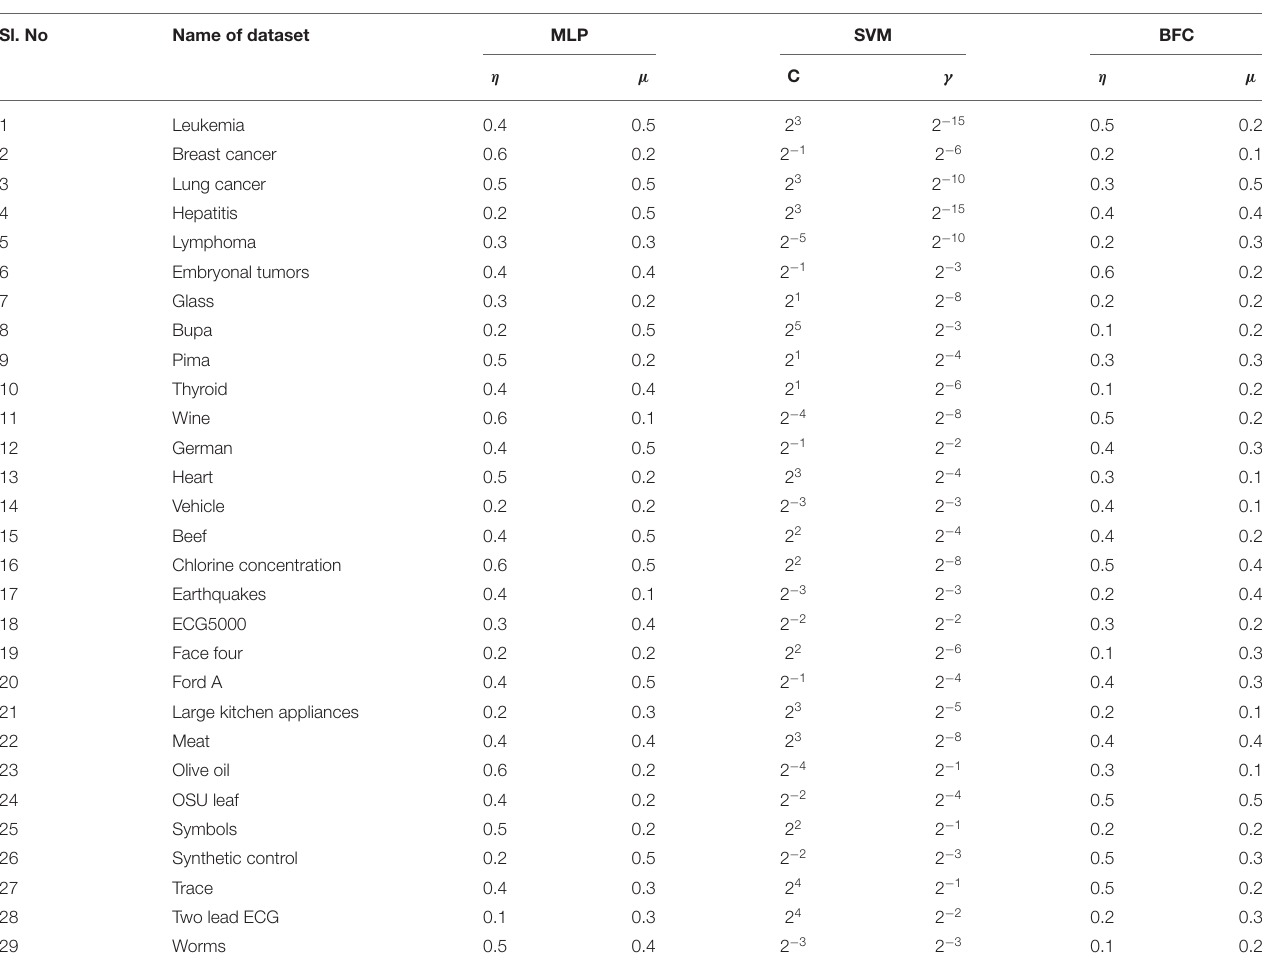
TABLE 1 | Parameter summary.